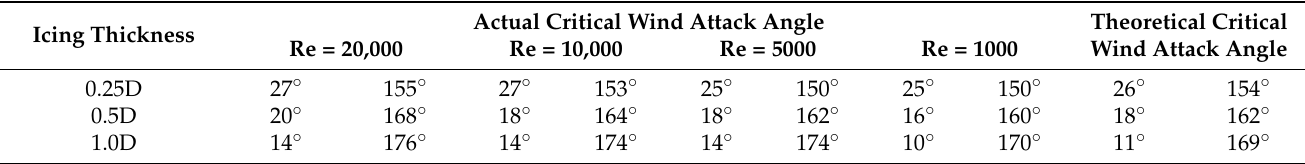
Table 4. Critical wind attack angle of different icing thickness at different wind speed.